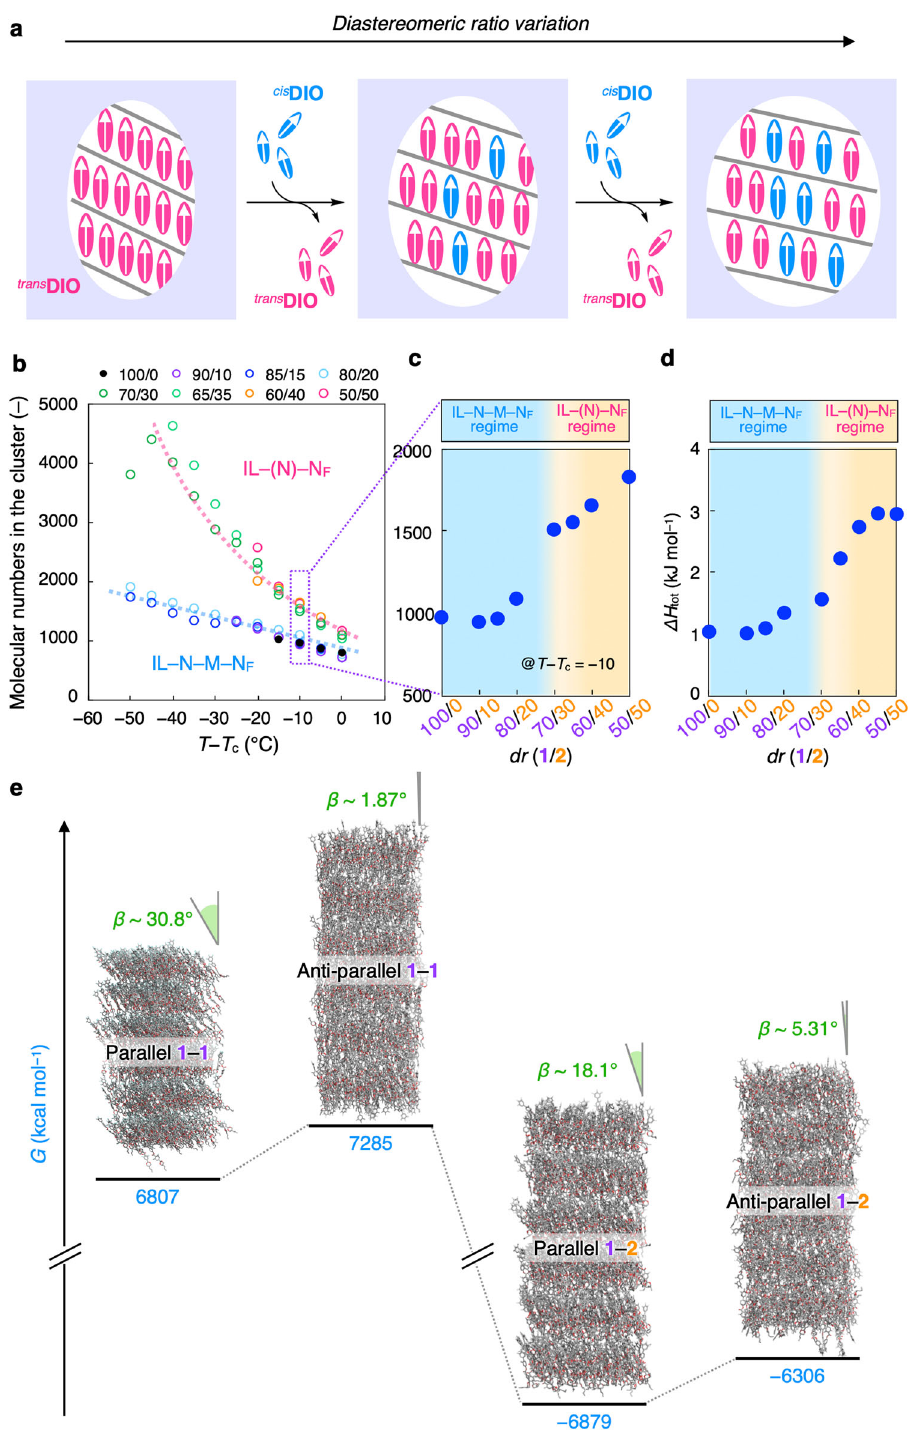
Fig. 4 Clustering effect on the evolution of phase sequence. a The schematic illustration of the growth process of the cybotactic cluster in the N F phase for 1 / 2 mixture. The exchange of cisDIO with transDIO promotes the anisotropic cluster growth. b The average molecular numbers in the cluster ( (cid:1) N ) as a function of T − T c of the 1 / 2 mixture with various dr (100/0 – 50/50). c The corresponding (cid:1) N as a function of dr ( T − T c = − 10 °C). d The relationship between latent heat ( Δ H ) and dr at T − T c = − 10 °C. Note: two distinct section of the phase transition types are indicated by color bands: IL – N – M – N F regime (blue), IL – (N) – N F regime (orange) in the panel c and d . e Energy diagram of the N F phase in 1 / 2 system generated by MD simulation. The snapshots (after 300 ns equilibration run) of four system consisting of parallel 1 – 1 , anti-parallel 1 – 1 , parallel 1 – 2 and anti-parallel 1 – 2 dimers obtained by all- atom MD simulation (for 1 – 1 dimer, 323 K; for 1 – 2 dimer, 288 K) are inserted. β denotes the average tilt angle of molecules in a smectic layer. The bottom values are the average total energy (simulation time: 200 – 300